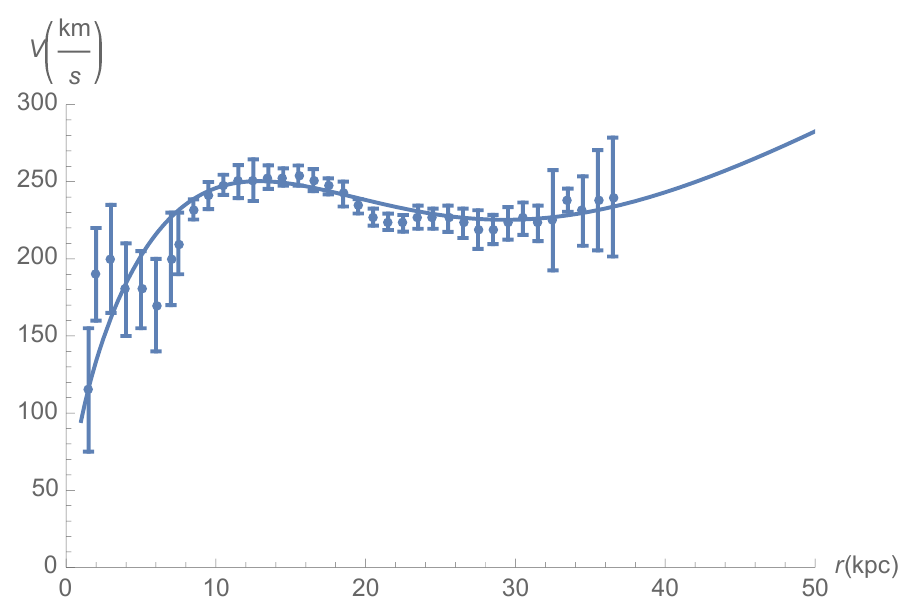
Figure 6. The rotational velocity curve for the galaxy M31. Dots are observed data [45], and the solid curve is the result of Equation (9) for the following parameters: a = 8 × 10 3 , b = 0.03, c =